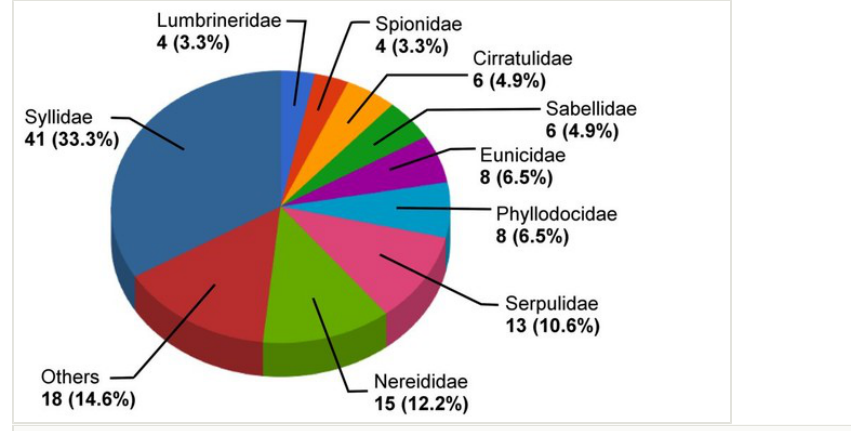
Distribution of species per family (abundance and percentage) for the most species-rich families in the MidMedPol dataset. Families with less than four species were combined in the category "Others". These are: Sabellariidae, Terebellidae (3 species each), Capitellidae (2 species), Amphinomidae, Aphroditidae, Chrysopetalidae, Dorvilleidae, Maldanidae, Oenonidae, Opheliidae, Orbiniidae, Pholoidae and Polynoidae (1 species each). Diagram based on the data from Suppl. material